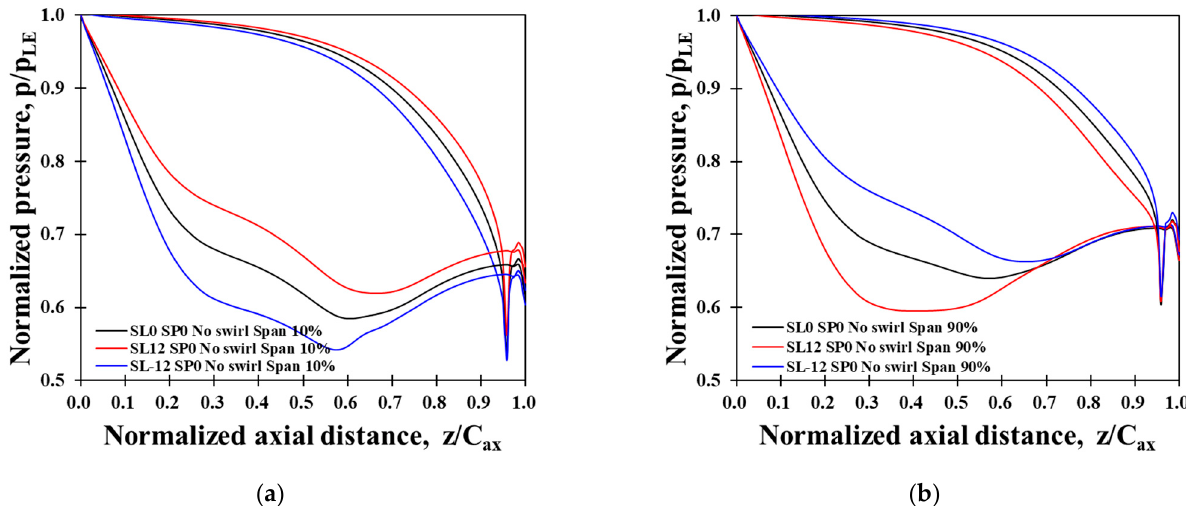
Figure 12. Loading distribution of NGV loading at 10, 50 and 90% span heights.